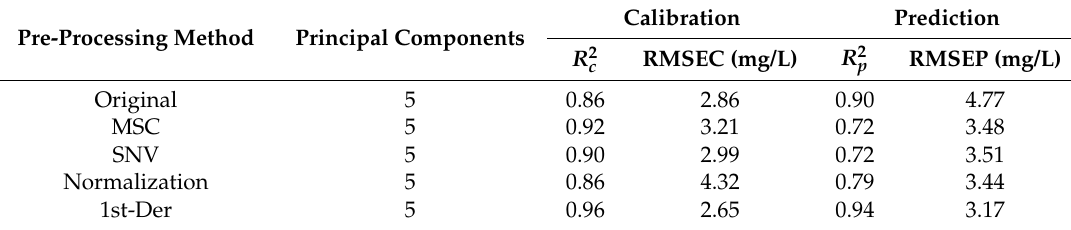
Table 2. The results of pre-processing method for calibration and prediction